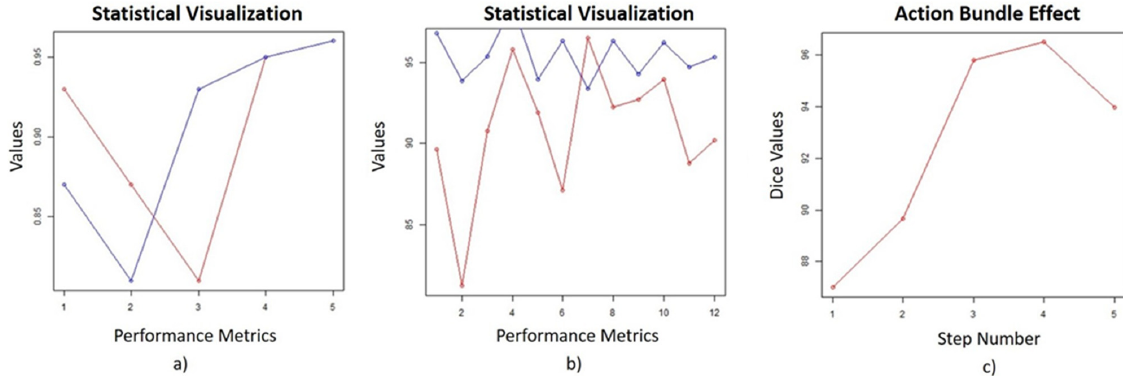
Figure 12. ( a )The statistical measures used by our method such as Acc , Dice , Jaccard index, Sen , and Spe are plotted for the PH2 and the ISIC 2017 skin segmentation dataset. The blue line denotes the performance metrics plotted for the PH2 dataset and the red line shows the metrics for ISIC 2017 skin segmentation dataset. In ( b ), the statistical measures of our method denoted as Dice, JSI, MCC, and the overall of these statistical measures are plotted for the three categories of skin lesions: naevus, melanoma, and seborrheic keratosis. While the other blue line and the red line denotes the metrics for the PH2 and the ISIC 2017 dataset, the highlighted points indicate the metric values such as Sen , Spe , and Acc for each of the categories on both the datasets. ( c ) Shows the action bundle effect. The various values of K are the different settings for the action bundle. We evaluate the effect of the value K on the dice values. We infer from the results that our segmentation results improve when we use both the modified ERM and action bundle.